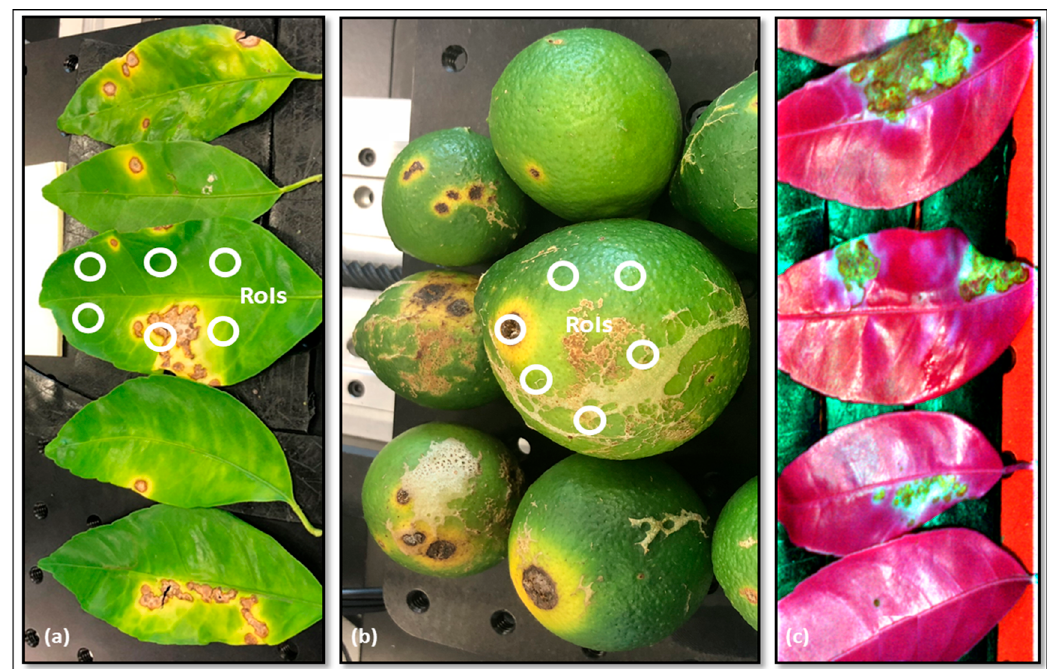
Figure 3. The indoor data collection system that was used for regions of interest (RoI) collection from citrus canker-infected Sugar Belle tangerine tissue samples. ( a ) Selection of RoIs on leaves and ( b ) immature fruits are indicated with white circles. Each sample (leaf or fruit) generates six spectral signatures by six randomly selected RoIs. ( c ) Leaf images showing canker symptoms on leaves with a false color of leaves with lesions in an infrared, blue (450–485 nm), green (500–565 nm), and red (625–740 nm) wavelengths.